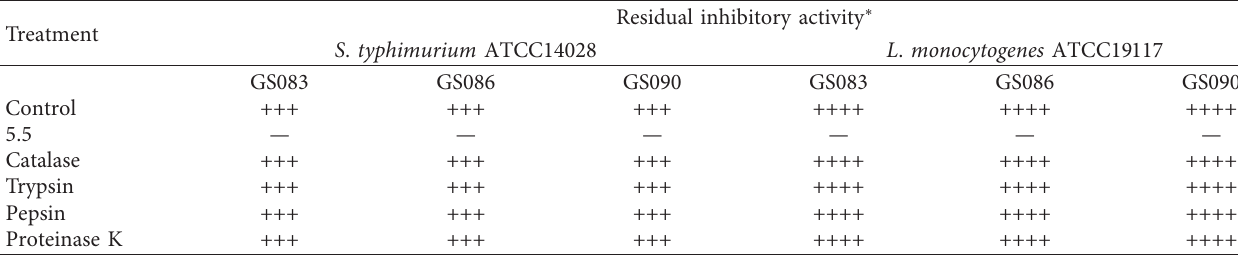
Figure 2: Antibacterial activity of L . plantarum GS083, GS086, and GS090 against 14 pathogen indicators. The zone of inhibition is expressed as the mean ± SD of three replicates. Table 1: Characterization of antibacterial compounds from three L . plantarum strains.